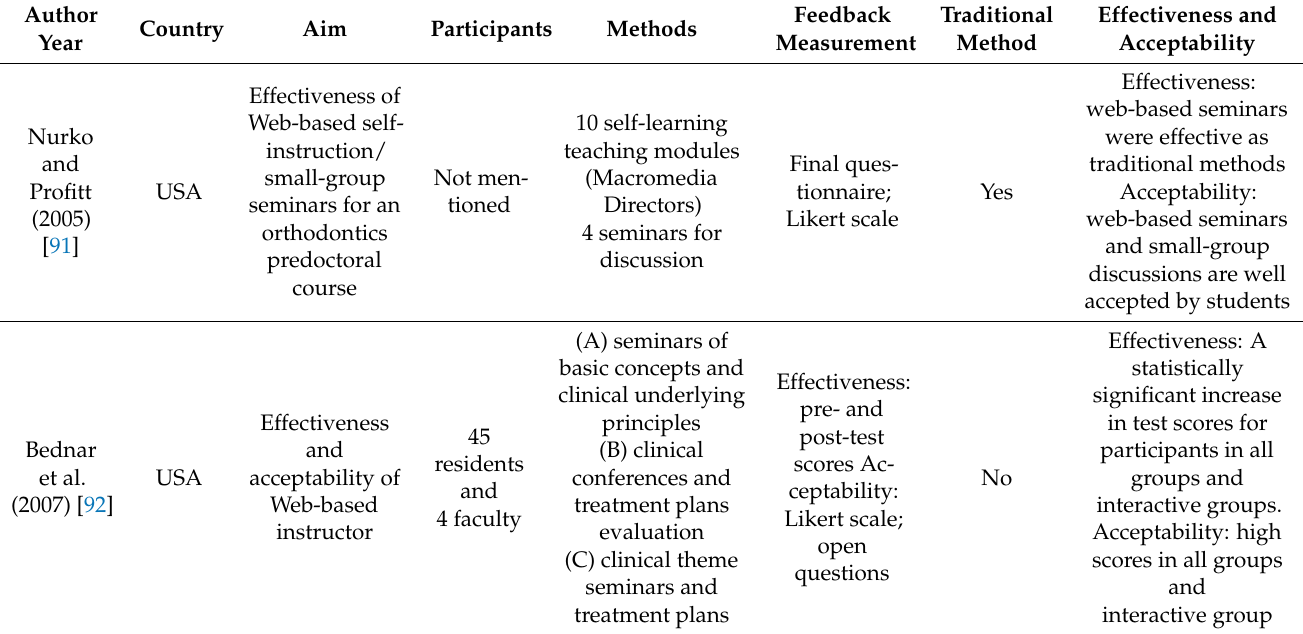
Table 1. Summary of the studies included in the systematic